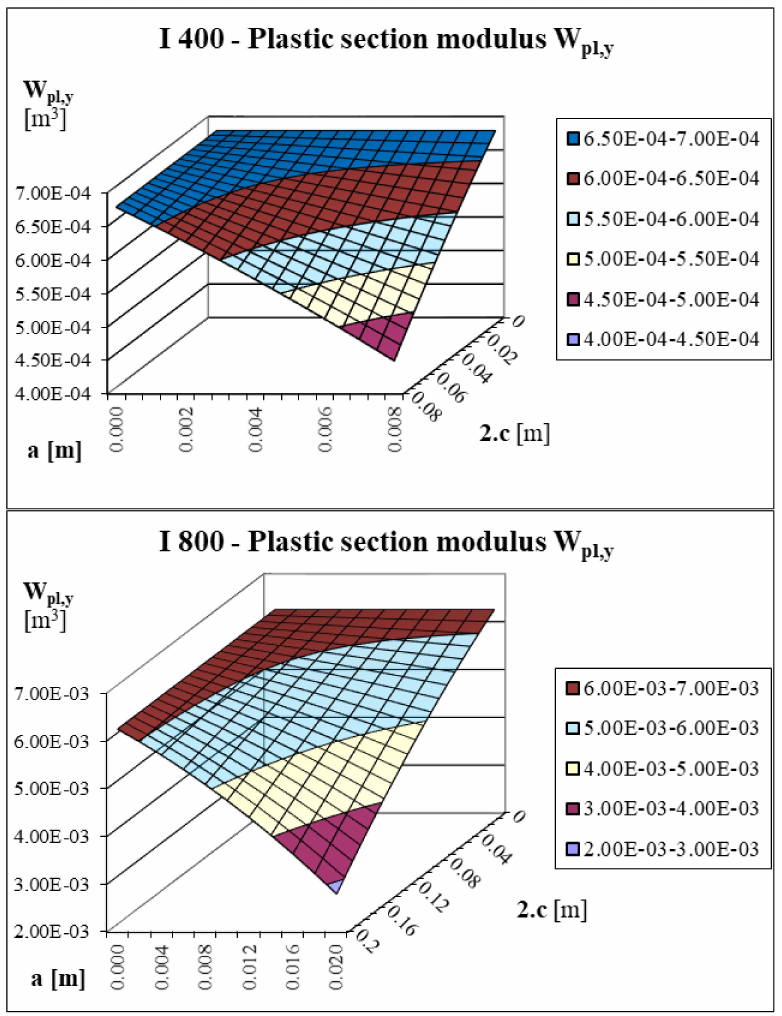
Figure 5. Influence of crack size on plastic section modulus W pl,y